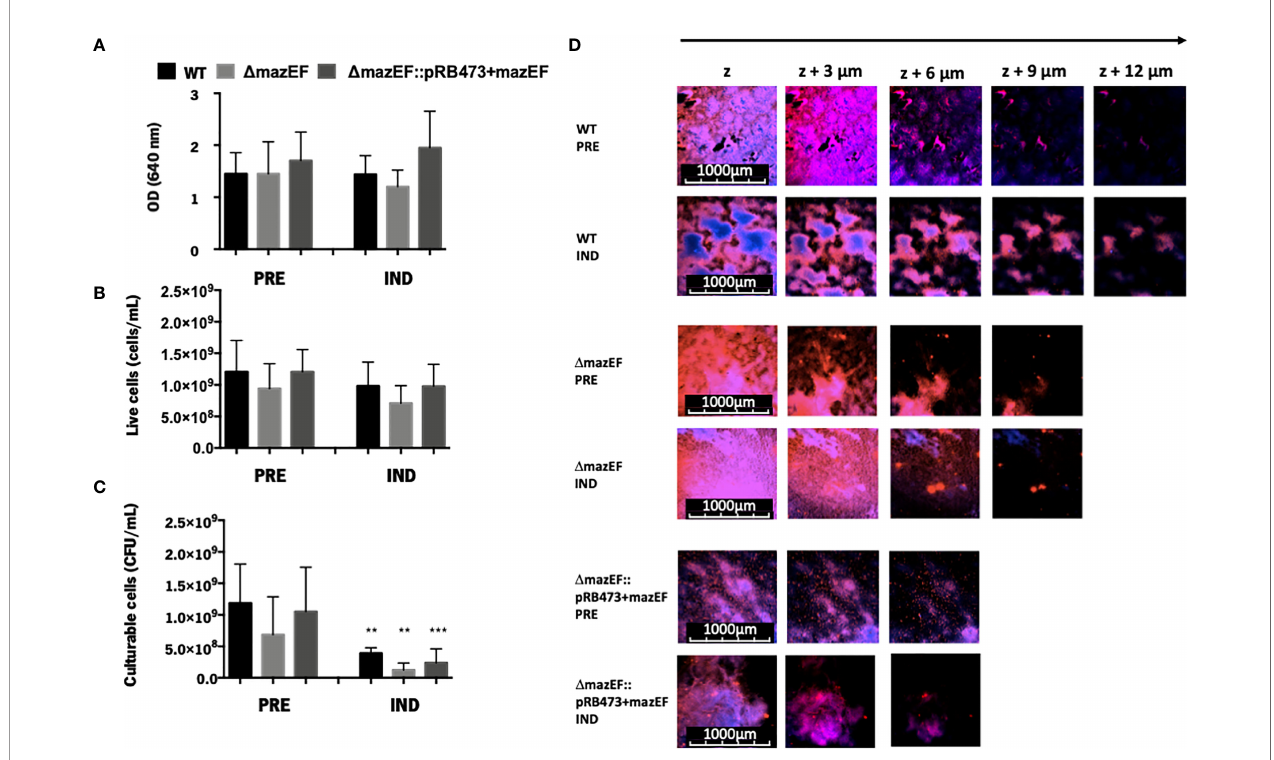
FIGURE 1 | The role of mazEF homologue on the regulation of the VBNC state in S. epidermidis 1457 48-hour old bio fi lms. Quanti fi cation of S. epidermidis bio fi lms grown under VBNC inducing conditions in terms of (A) Total amount of cells (OD); (B) Concentration of live cells ( fl ow cytometry); and (C) Concentration of culturable cells (CFU/ml). Results are represented as the mean + standard deviation of at least 3 independent experiments. Statistical analysis was performed with One-way ANOVA with Tukey ’ s multiple comparisons test, ** p < 0.01,*** p < 0.001. (D) Bio fi lm structure analysis assessed by CLSM. The images shown are representative of 2 independent experiments. PRE, Prevented VBNC; IND, Induced